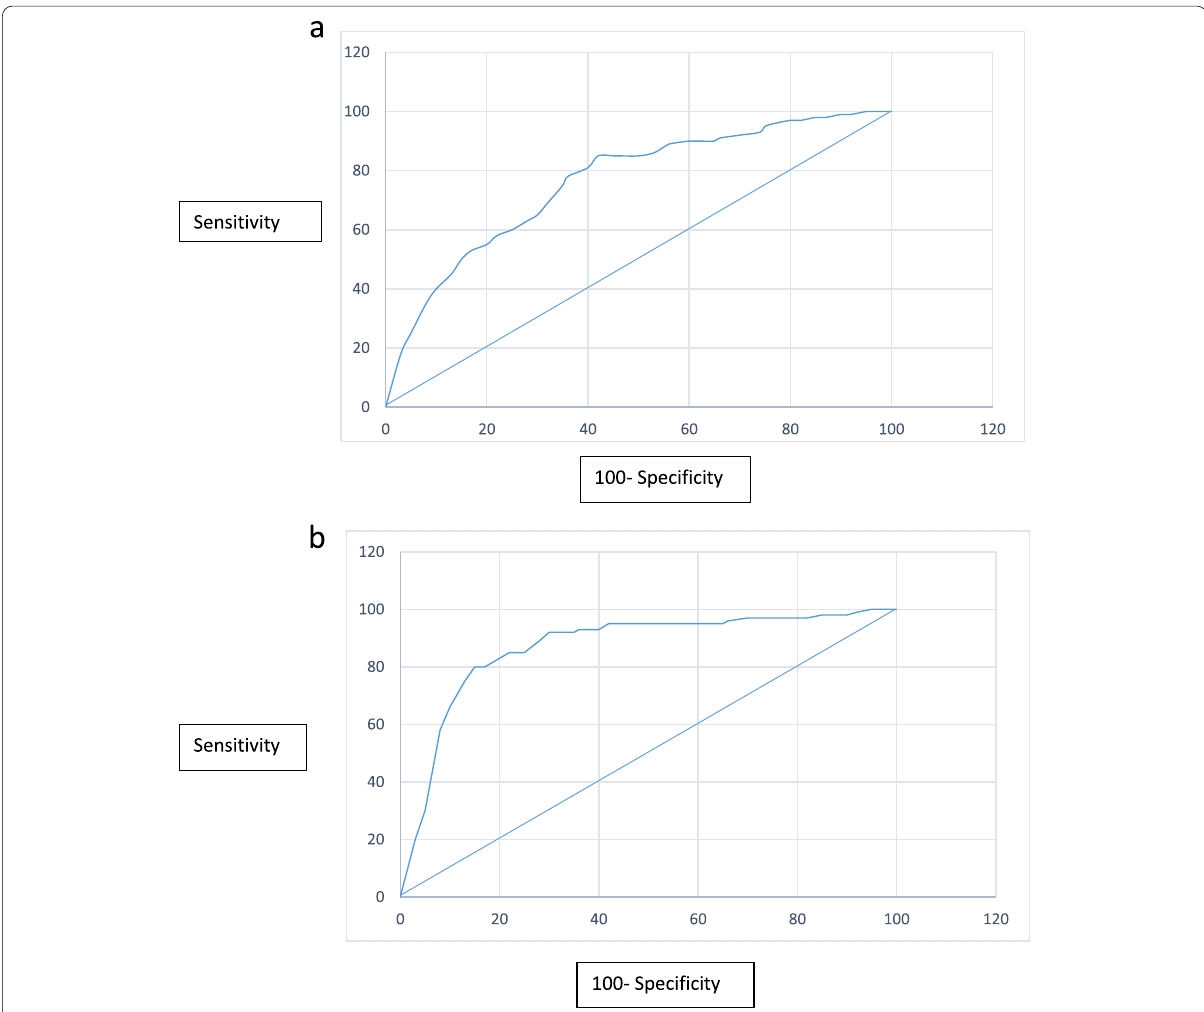
Fig. 1 a, b Receiver operating characteristic (ROC) and area under curve (AUC) for pulmonary valve annulus z -score and great artery annulus ratio (PVA/AVA), respectively. Sensitivity and specificity were calculated at different cut-off values. The AUC for great artery annulus ratio was higher than that of PVA z